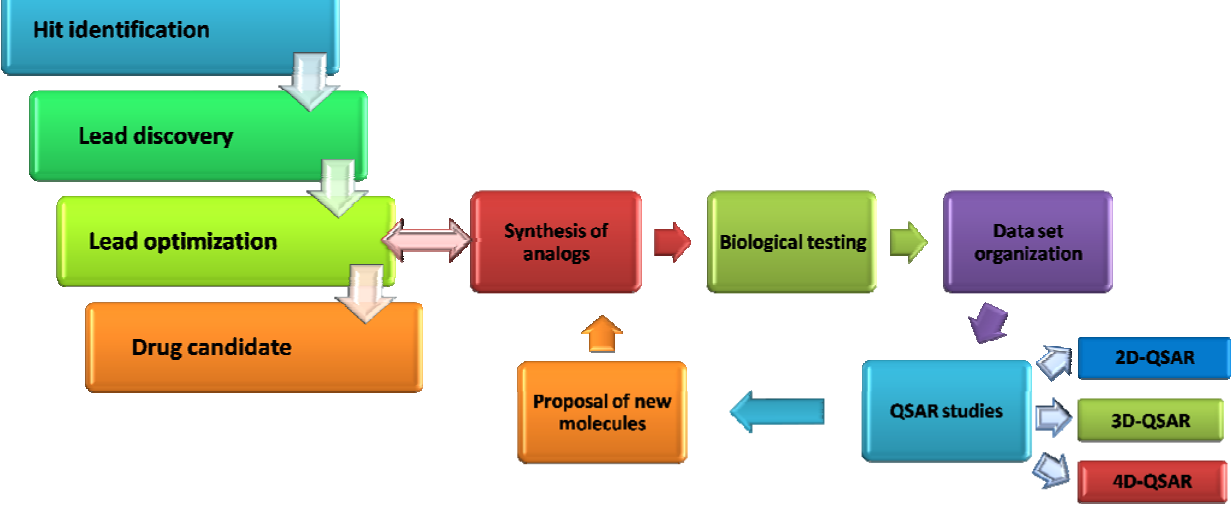
Figure 1. Schematic representation of the processes included in a lead optimization from the hit identification. QSAR methods are essential to reach this